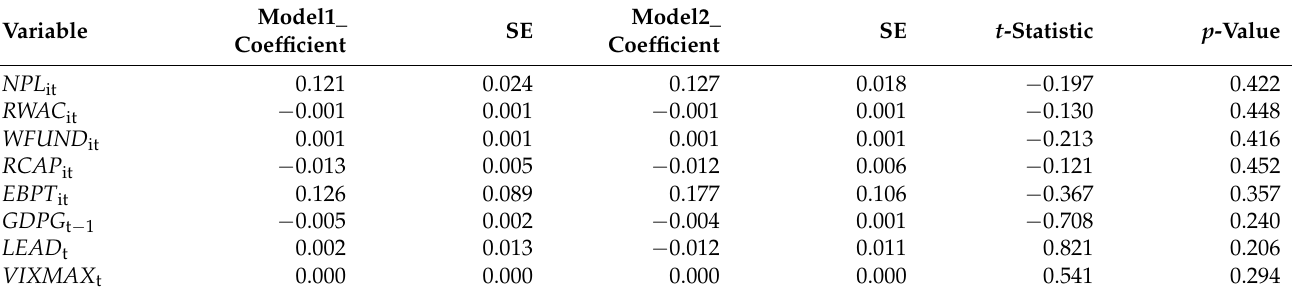
Table A1. Comparison of pre-crisis (1) and pre-crisis (adjusted) (2).